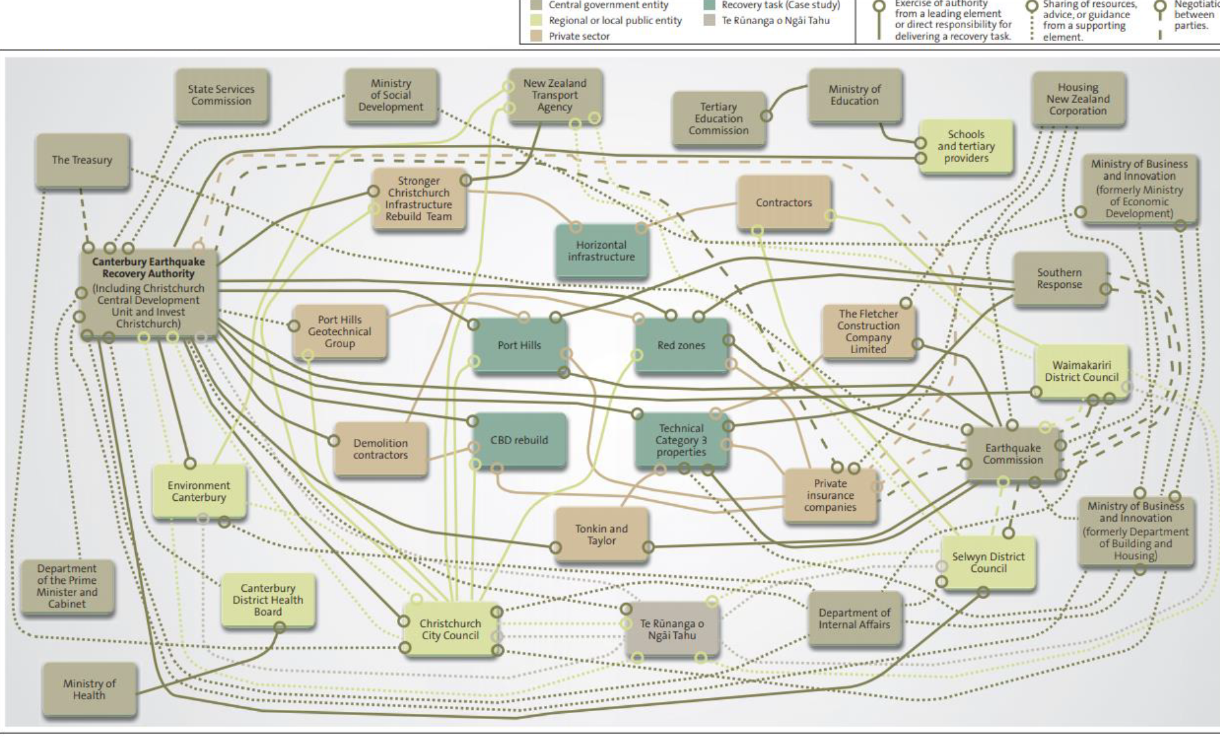
Figure 2. Relationships between public sector entities, private companies, Ng¯ai Tahu, and Canterbury recovery tasks (Controller and Auditor- General, 2012, p.